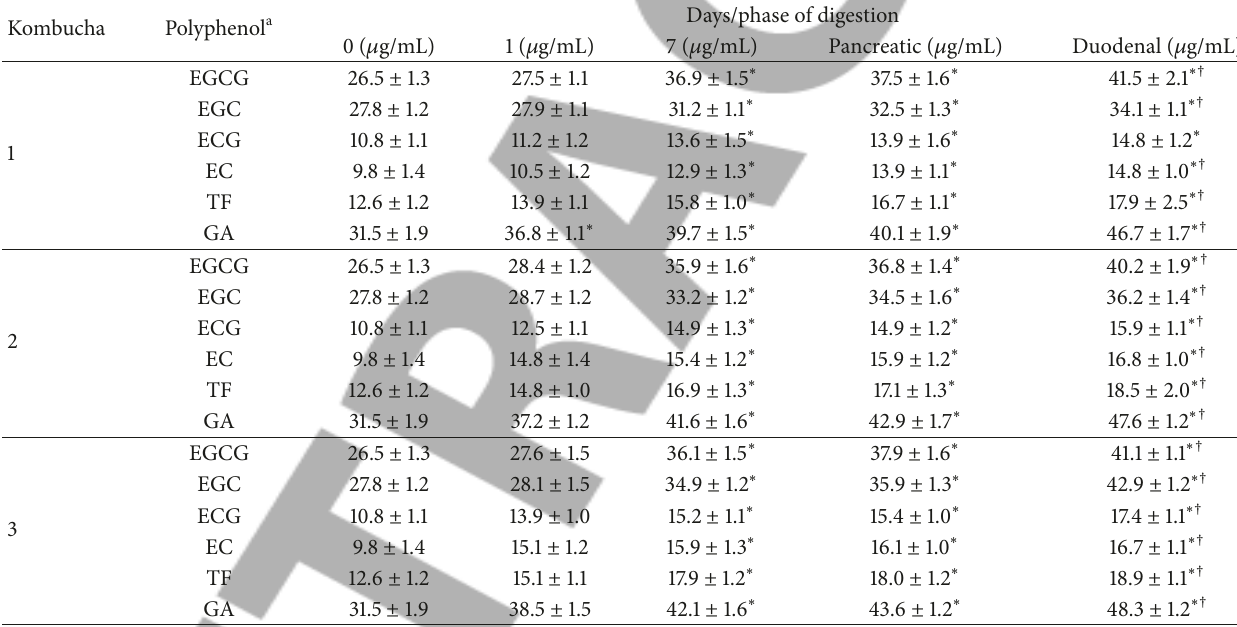
Table 3: Changes in the polyphenol contents in the three Kombucha cultures throughout the 7-day period of analysis expressed as mean ± SEM. ∗ 𝑃 < 0.05 versus the value of each tea at day 0. † 𝑃 < 0.05 versus the value of each tea at day 7.